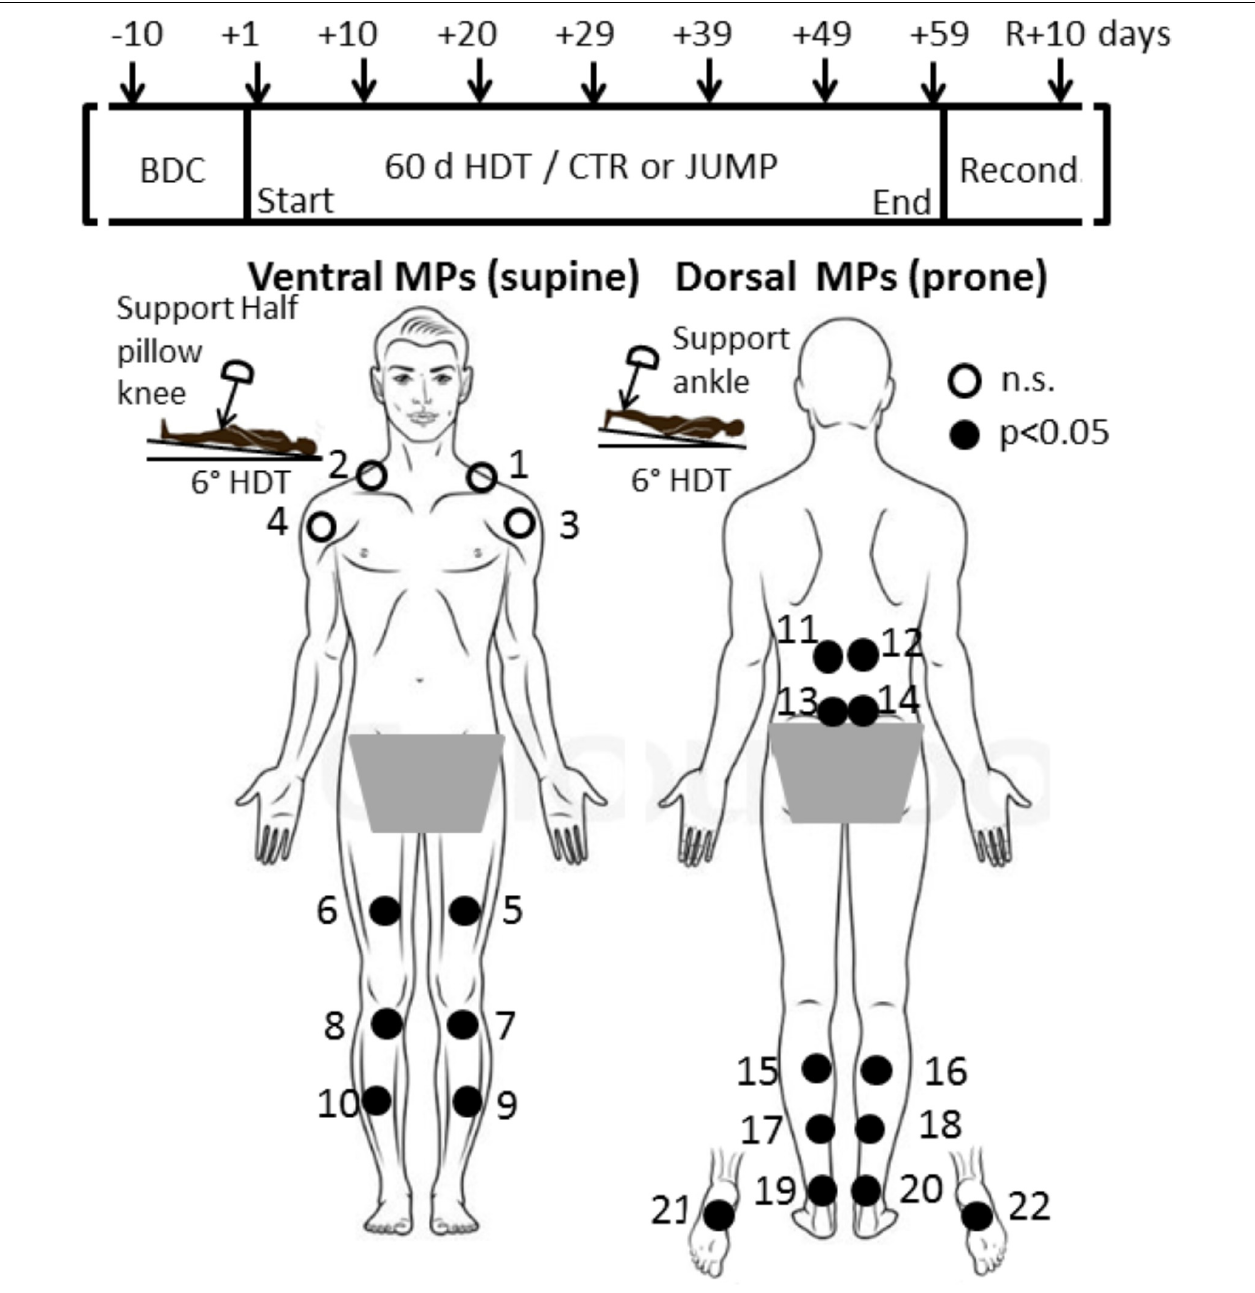
FIGURE 1 | RSL study design and protocol. (Upper) Shows time points of myotonometric measurements (arrows) before (BDC), during 6 ◦ ; head-down tilt bed rest (HDT+1 to HDT+59), and following 10 days of reconditioning (R+10). (Lower) With body chart of skin measurement points (MPs) located at upper body, lower back, legs, ankle and foot sole. In a session, myotonometric measurements on premarked skin MPs (closed circles) always started at HDT prone with trapezius MP1/2 (first MP), MP3/4, deltoid; MP5/6, rectus femoris; MP7/8 patellar tendon; MP9/10, tibialis anterior; and supine with MP11/12, erector spine; MP13/14, lumbar multifidus; MP15/16, gastrocnemius; MP17/18, soleus; MP 19/20, Achilles tendon; and plantar fascia/Flexor digitorum brevis, MP21/22 (final MP). A knee and ankle half pillow support was used during supine and prone HDT positioning for leg joint angle standardization in particular